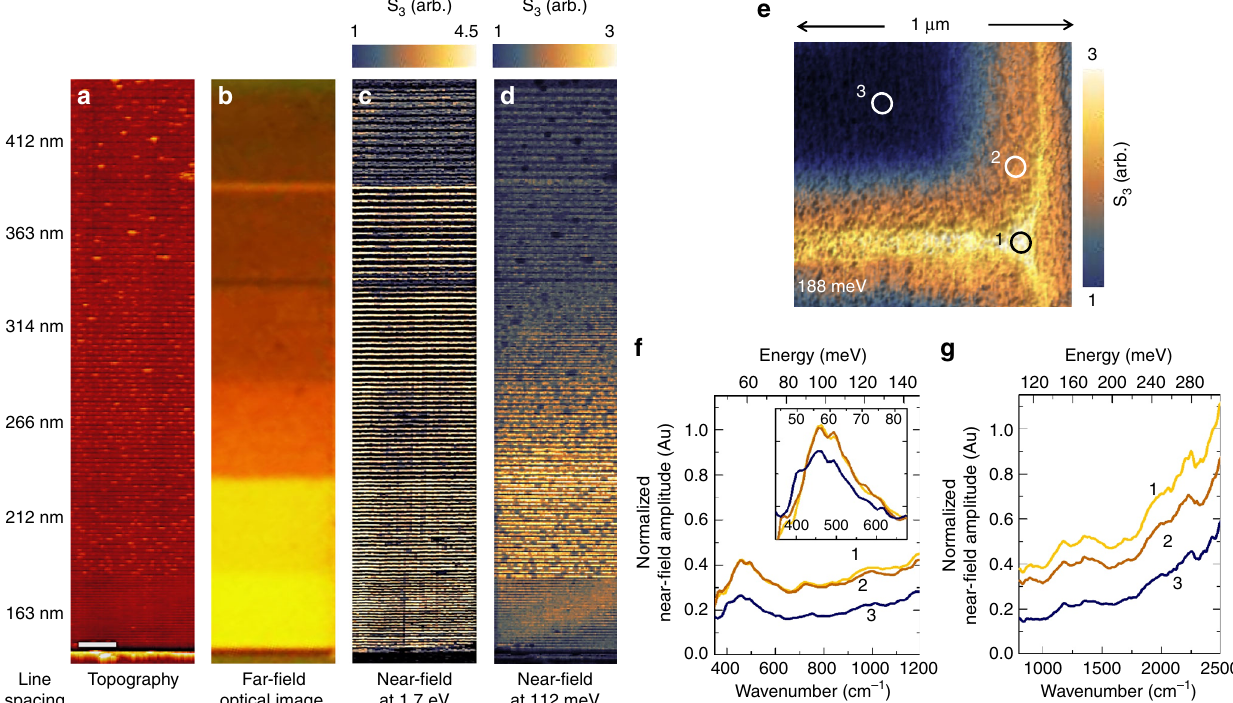
Fig. 2 IR and visible near- fi eld characterization of SmS metamaterials created via AFM lithography. a The topography of a color gradient MM with decreasing spacing between the patterned lines (listed on the left) is shown for a depth of ~12 nm. The scale bar is 500 nm. A far- fi eld optical image of the same gradient MM is shown in b ; the color change from red to golden is achieved by altering the lithographic line spacing. Room-temperature near- fi eld images are collected at 1.7 eV ( c ), and 112 meV ( d ). The near- fi eld 3rd harmonic amplitude is shown in false-color, where blue indicates regions of semiconducting conductivity and gold indicates regions of metallic conductivity. e The near- fi eld amplitude at 188 meV (1515 cm − 1 ) and 295 K is shown in false color for a 1 μ m 2 region of a grating pattern. The near- fi eld amplitude change of the patterned area (in gold) is normalized to the semiconducting response (in blue). Three locations are marked in the image, indicating golden IV (1), transition (2), and semiconducting (3) regions of the MM. Broadband near- fi eld spectroscopy (normalized to a gold thin fi lm) at 295 K is shown in f , g , for the locations speci fi ed in the 1 μ m 2 image, indicating the presence of the localized golden IV phase on the surface of the SmS. The exciton peak at 58 meV (468 cm − 1 ) is observable in all three regions. The inset in f , shows the exciton peaks with the background removed to highlight the slight frequency shift with applied